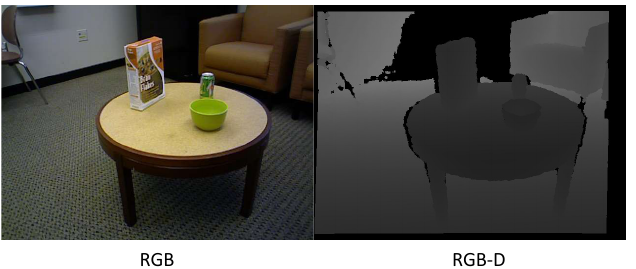
Figure 5. RGB and RGB-D image from RGB-D Object Dataset [68]. Pixels in an RGB-D image are used to represent how far away an item is from the screen. Those closest to the camera have the greatest pixel values, while those farthest away from the camera have the